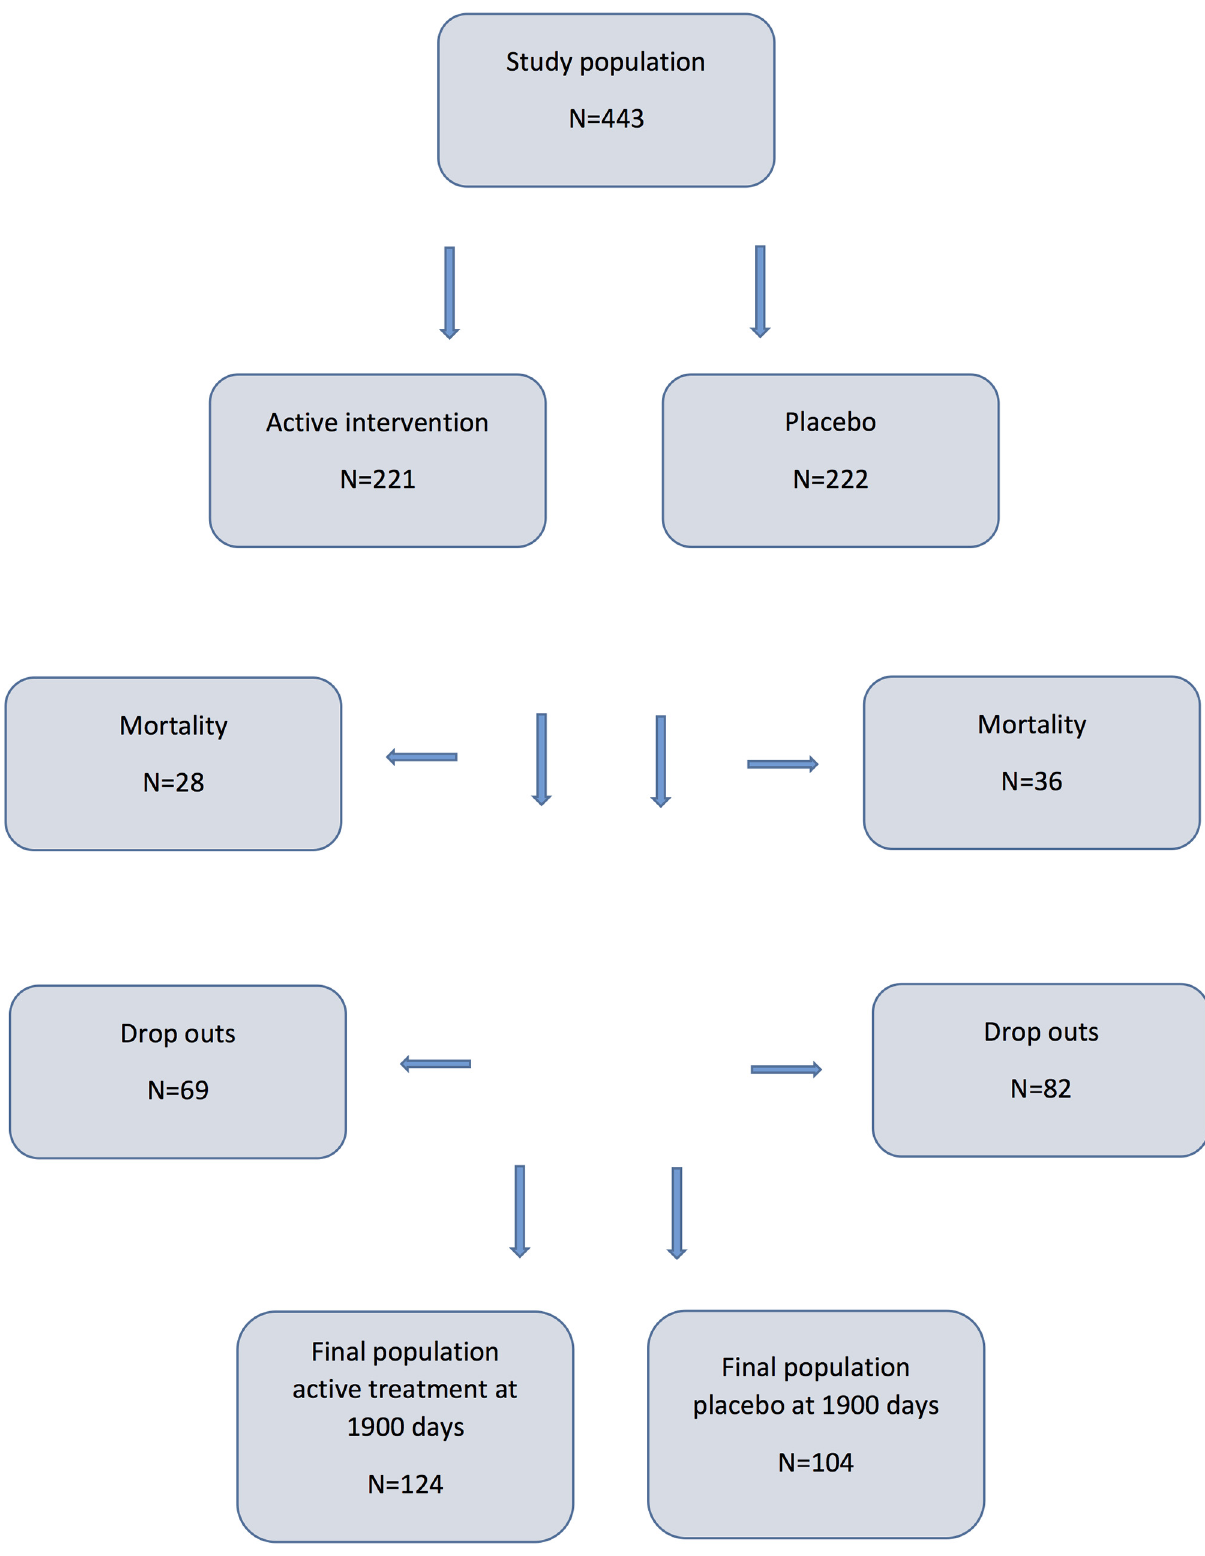
Fig 1. CONSORT diagram illustrating the design of the study.